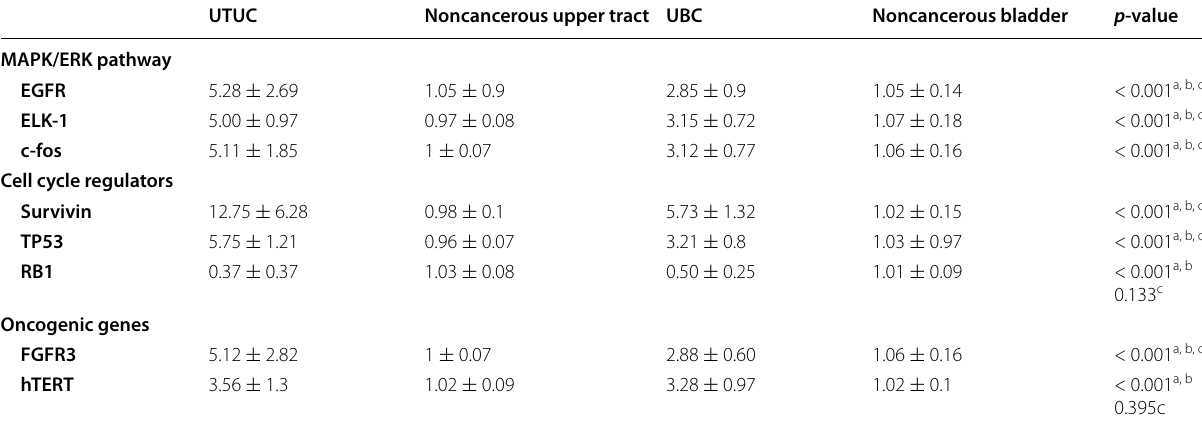
a p -value between UTUC and noncancerous upper tract b p -value between UBC and noncancerous bladder c p -value between UTUC and UBC